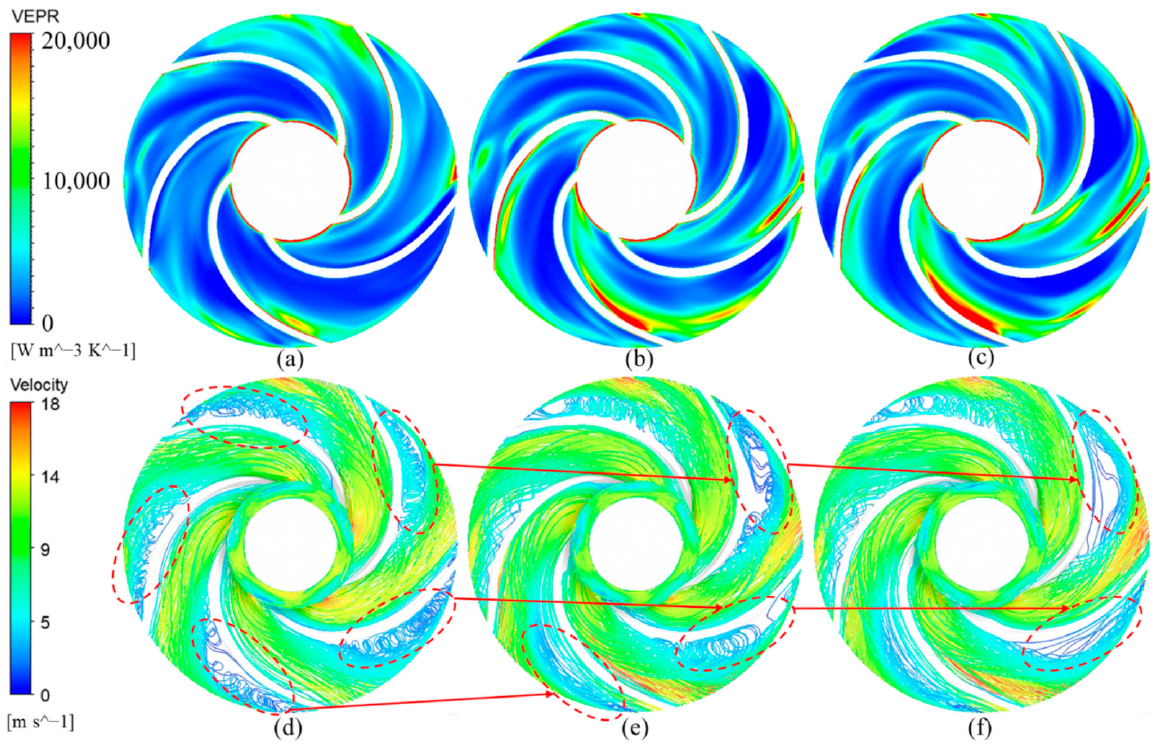
Figure 14. Comparative analysis of the VEPR and velocity streamlines between impellers. ( a ) VEPR of impeller1, ( b ) VEPR of impeller3, ( c ) VEPR of impeller5, ( d ) Streamlines of impeller1, ( e ) Stream‑ lines of impeller3, ( f ) Streamlines of